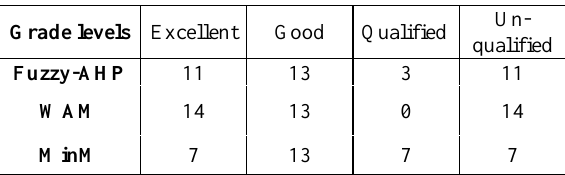
Table 3 The number of map sheets that are evaluated by three methods in each grade level.